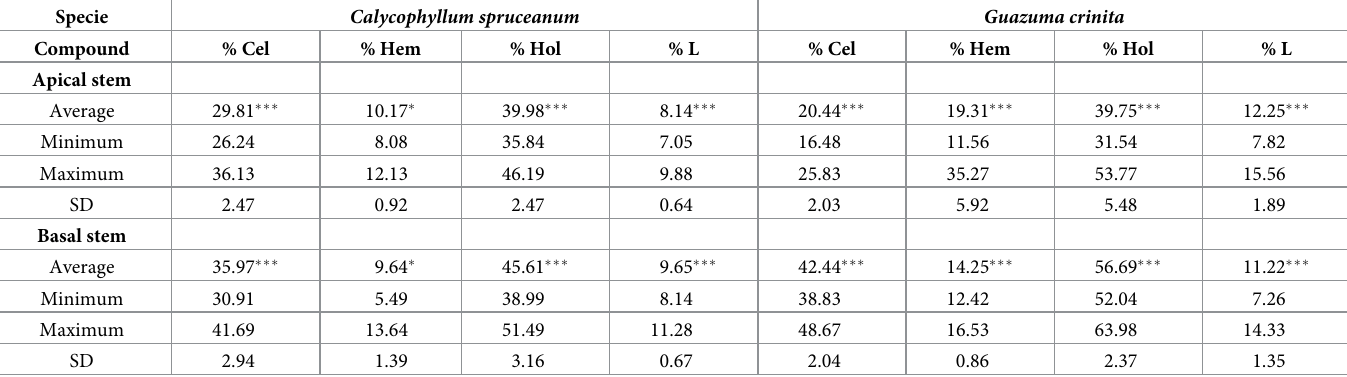
Table 1. Descriptive statistics of the chemical composition of C . spruceanum and G . crinita